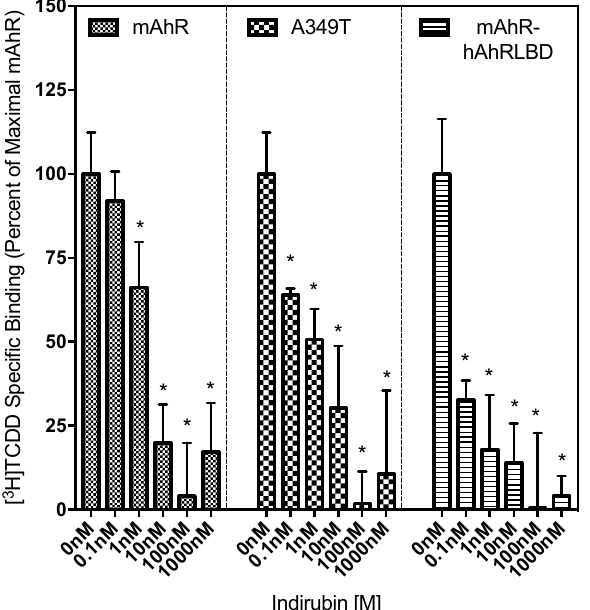
Figure 7. A349T mutation has no significant effect on the relative affinity of IR for mAhR. In vitro synthesized mAhR, mutant AhR, or mAhR-hAhRLBD chimeric protein was incubated in the presence of 2 nM [ 3 H]TCDD and indicated concentrations of IR for 30 min and [ 3 H]TCDD bound to the protein fraction was measured by the hydroxyapatite assay. The unprogrammed TNT lysate was used as a nonspecific binding control, and specific binding was calculated as a difference between the total and nonspecific reactions. Values represent the mean ± SD of nine individual replicate analyses. The asterisks indicate the values that are significantly different from the no-competitor reaction, as indicated by the Two-Way ANOVA with p < 0.05. The relative affinity of IR for the mAhR, A439T and mAhR-hAhRLBD was 17.67 ± 1.66, 4.61 ± 1.87 and 0.82 ± 0.28 nM, respectively, as determined using nonlinear regression (three-parameter) analysis of the competitive binding results.